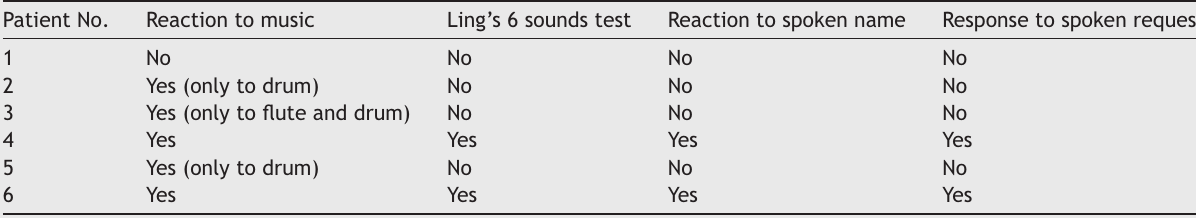
Individual reaction to sounds and spoken language in six autistic children with cochlear implants. Patient No.